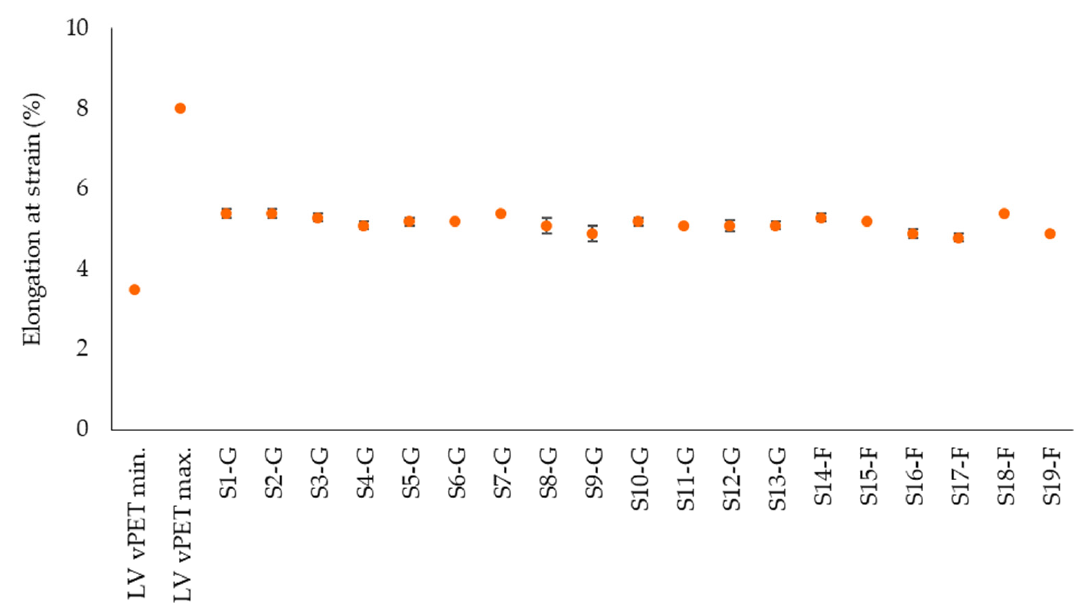
Figure 9. Experimentally determined elongation at flexural strength of rPET samples in comparison with literature values for vPET.